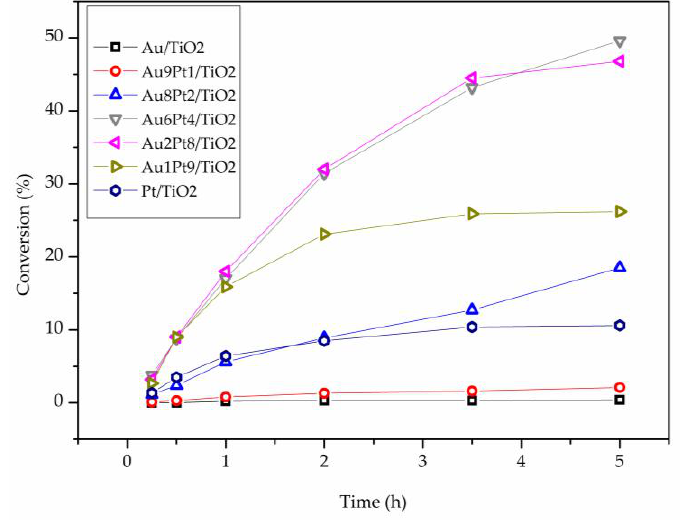
Figure 5. Reaction profile of Au-Pt catalyst in the base free glycerol oxidation . Catalysts 2018 , 8 , x FOR PEER REVIEW